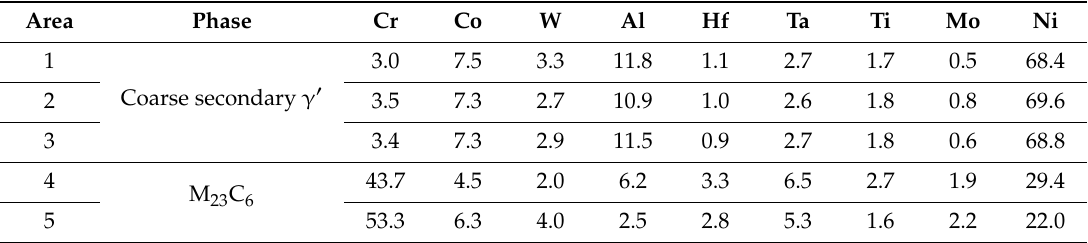
Figure 18. Microstructure of "Chinese script" carbide in interdendritic space, STEM-HAADF.